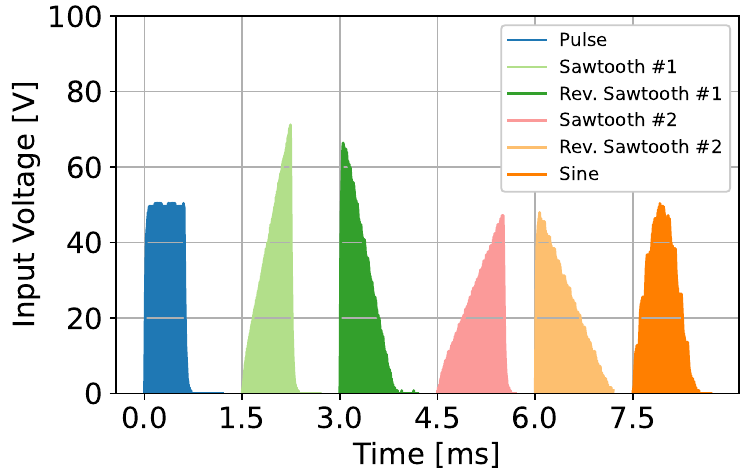
Figure 1. The stimulus waveform that we used in the